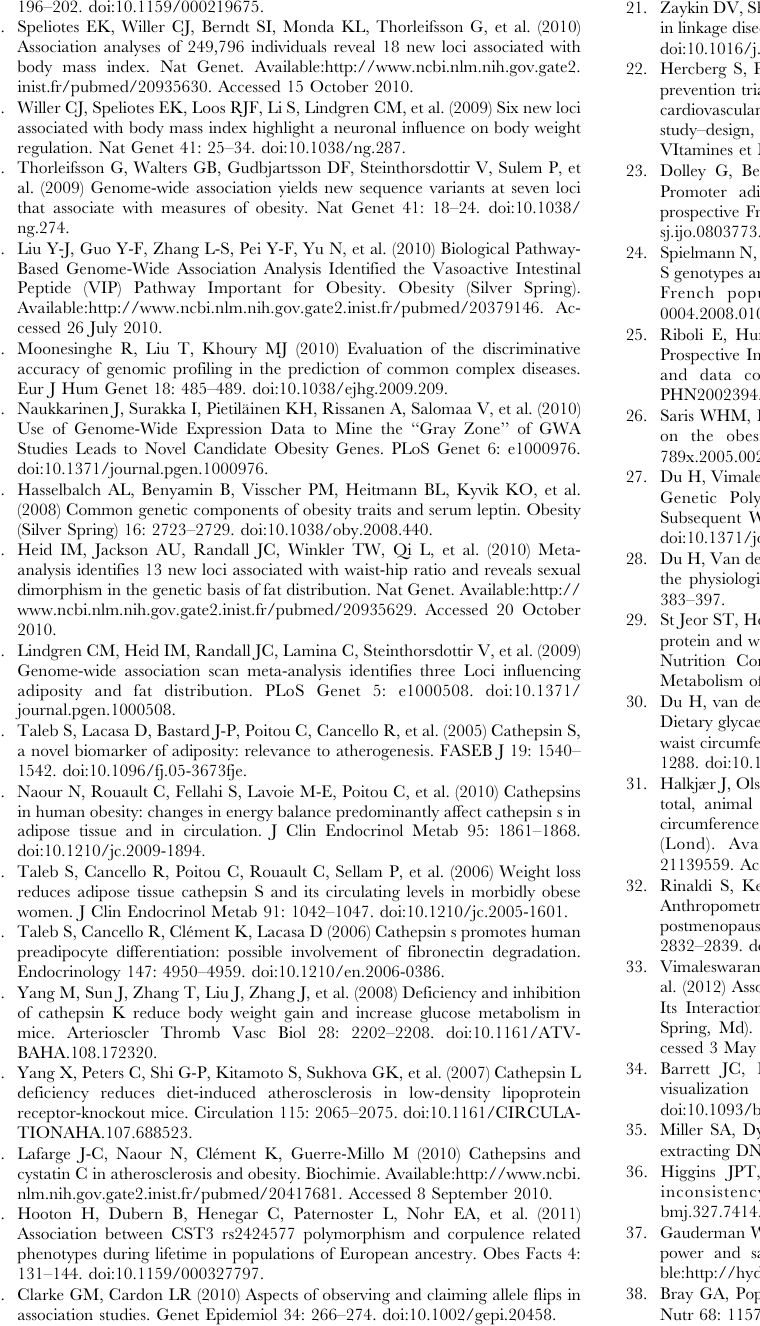
Table S1 Dominant and recessive models for associa- tions which were significant when assuming an additive